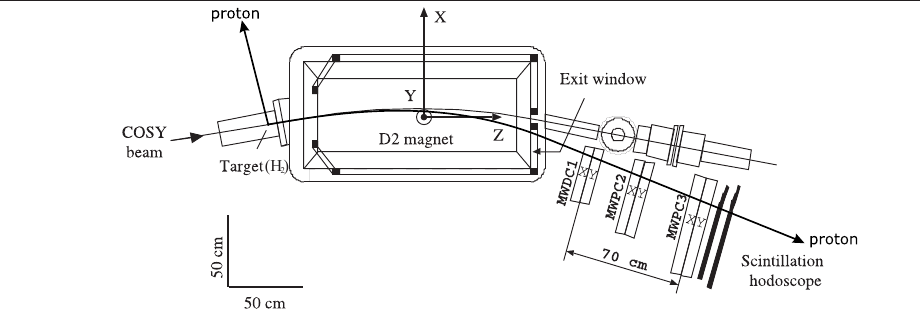
Figure 1. Scheme of the pp → pp reaction being registered in the ANKE forward detector. Other ANKE detectors are not